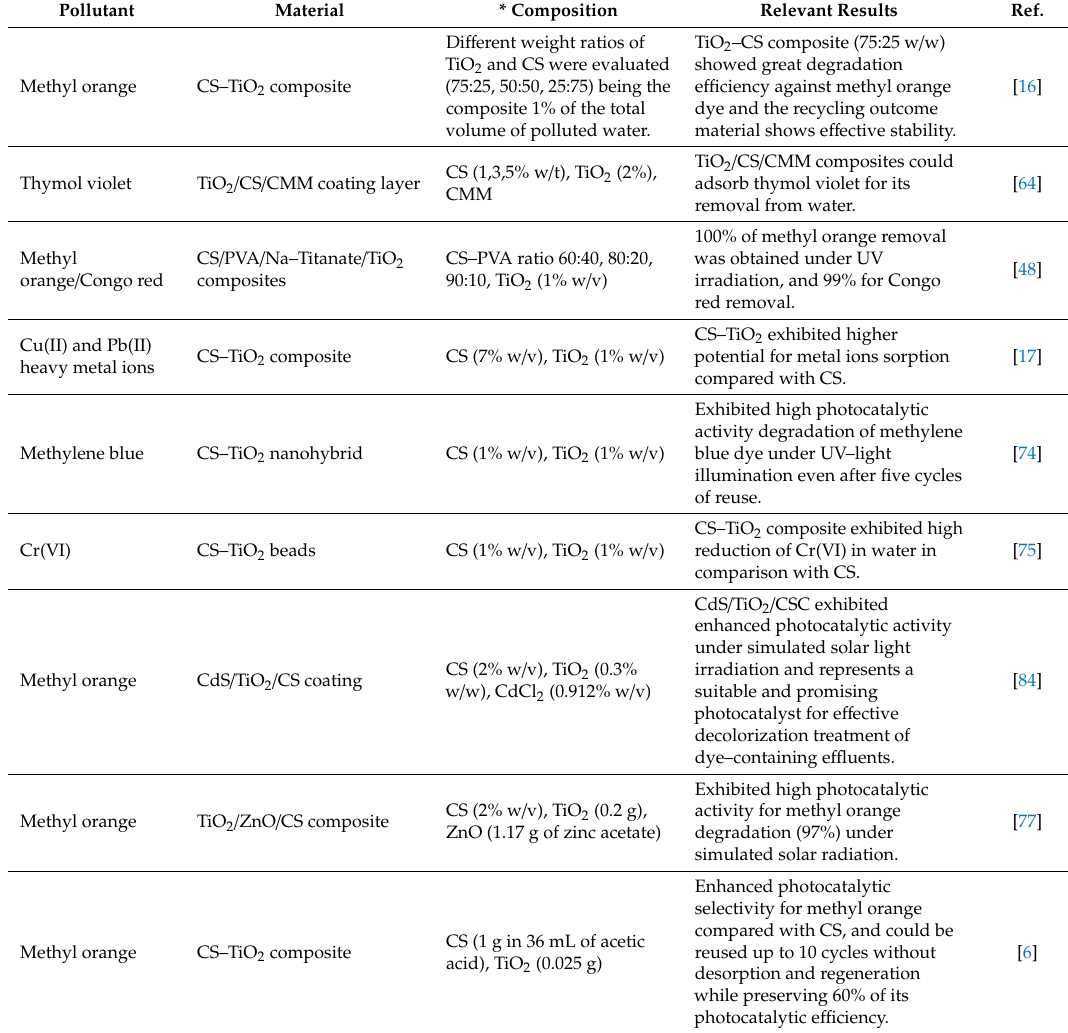
Table 5. Photocatalytic activity of a CS–TiO 2 composite for di ff erent water pollutant degradation. Pollutant Material * Composition Relevant